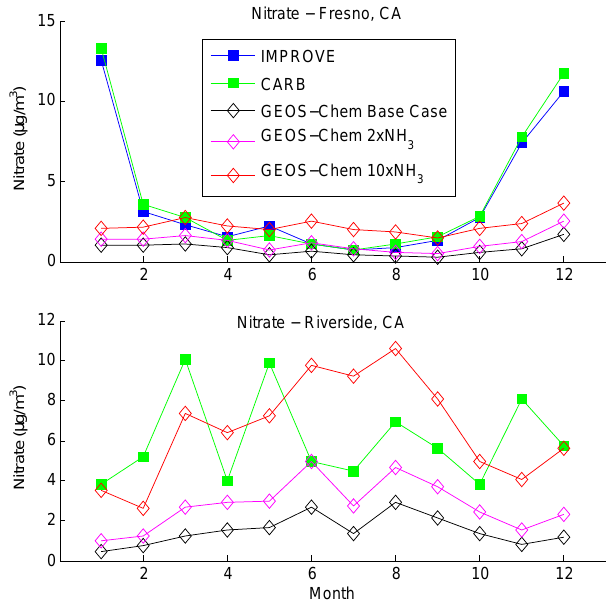
Fig. 12. 2009 monthly predicted aerosol nitrate at Fresno, CA and Riverside, CA in GEOS-Chem ammonia sensitivity simulations (base case, 2 × NH 3 emissions, and 10 × NH 3 emissions) compared with measured